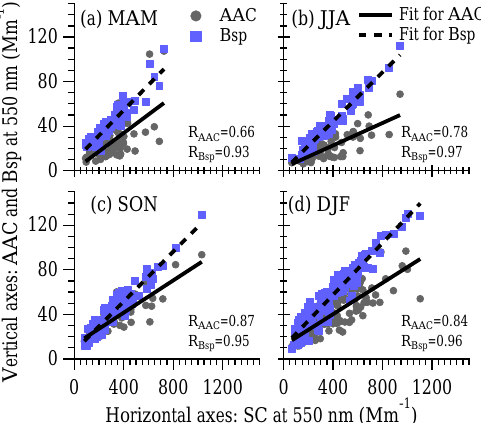
Figure 6. Relationships between 550nm AAC and SC (solids square in blue) and between 550nm Bsp and SC (solid cycles in gray) in spring (a) , summer (b) , autumn (c) and winter (d) .